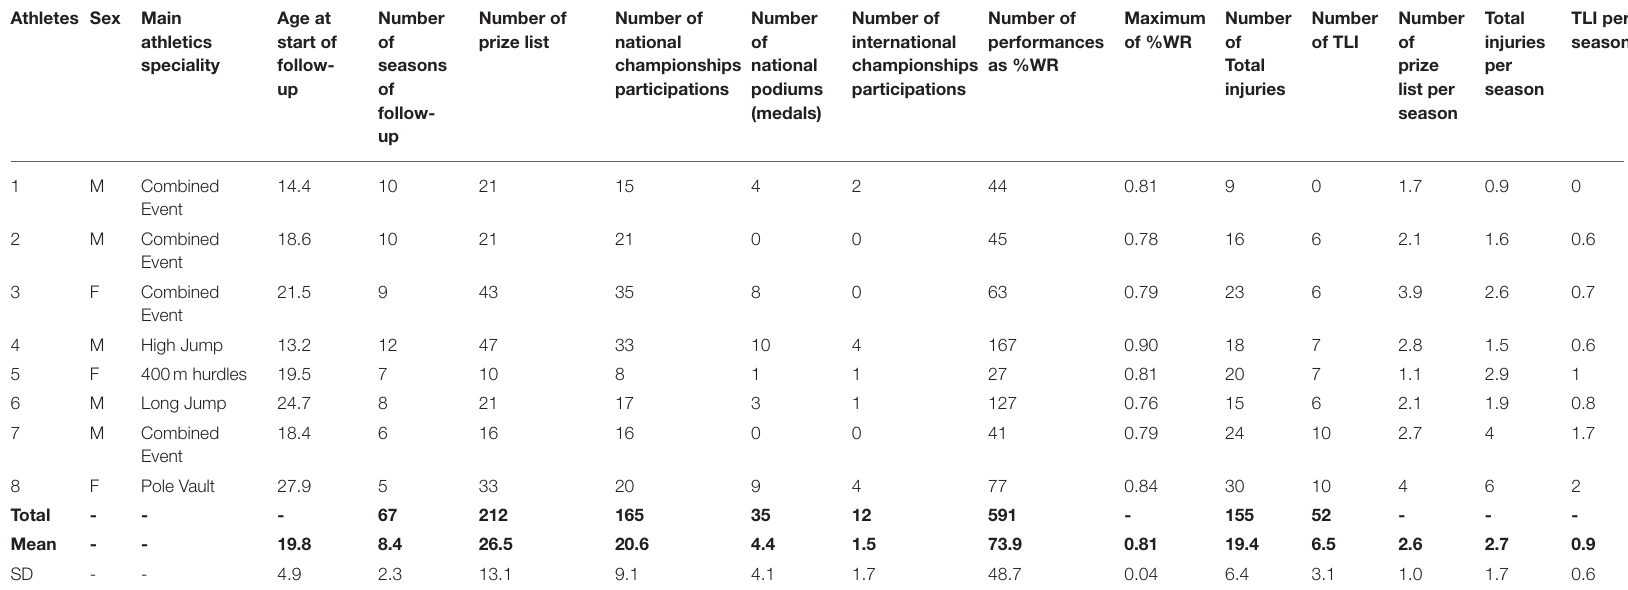
TABLE 1 | Characteristics of the included athletes with the information on competitions, prizes won, performance expressed as percentages of the World Record (%WR) and on injuries with injuries and time loss injuries (TLI). Athletes Sex Main